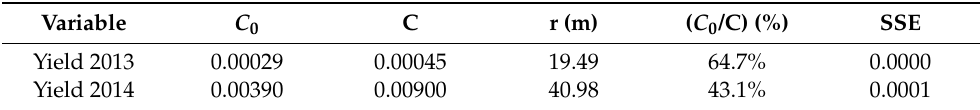
Table 1. Semi-variogram model parameters of the yield data. The best fit was achieved with spherical